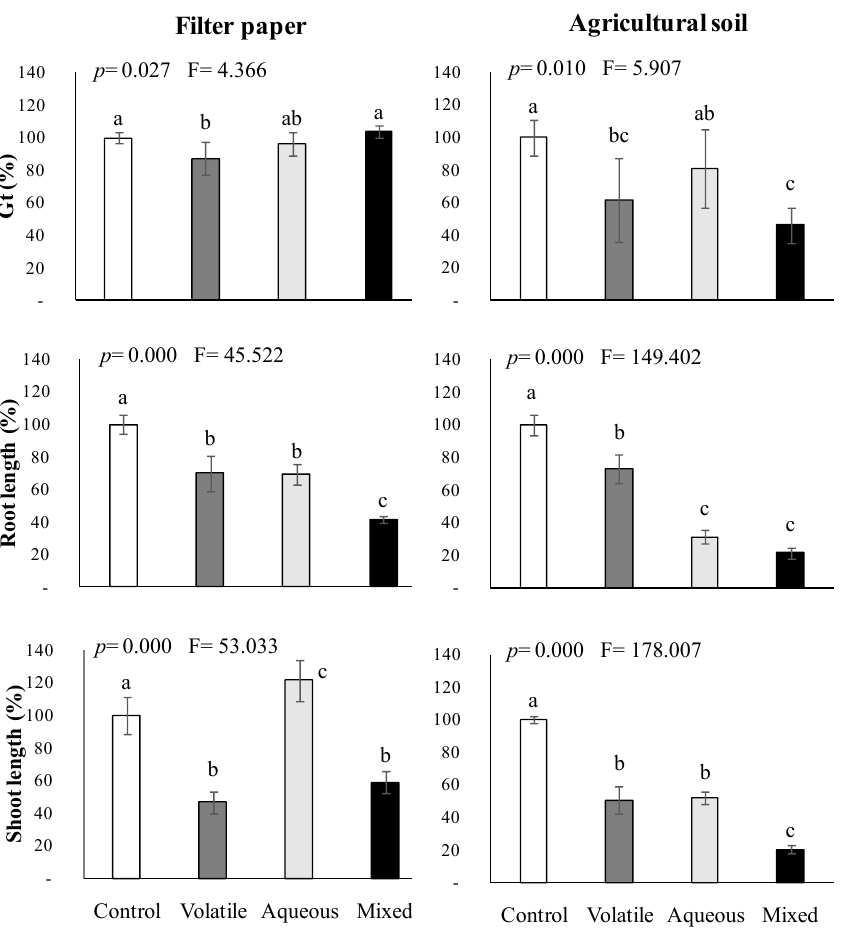
Figure 4. Effects of volatile compounds naturally released from the flowering foliage of Cytisus scoparius and its aqueous extract, acting separately or concomitantly in 1 L hermetic chambers, on the total percentage of germinated seeds (Gt) and early growth of Amaranthus retroflexus placed on filter paper or agricultural soil. Mean values of four replicates are represented in percentage relative to control. Error bars represent standard deviation (S.D.). p - and F-values of the effects of treatments from one-way ANOVA or Kruskal-Wallis H tests are shown. Mean values labeled with distinct letters denote statistically significant differences among treatments (post-hoc LSD or Tamhane’s T 2 test). So far, only an approach by Dias and Moreira [15] studied the interactions between the volatile compounds emitted by a plant and its aqueous extract. These authors discovered that the volatiles emitted by Cistus ladanifer intact leaves inhibited the germination of Trifolium subterraneum , but only when the water-soluble compounds were present. From our results (Figure 4), when assayed on filter paper, we found significant phytotoxic interactions between the naturally emitted VOCs and the aqueous extract on the root elongation of A. retroflexus , attaining 60% inhibition ( p ≤ 0.001). Conversely, inhibition of germination and shoot growth of the seeds placed on filter paper was only attributed to the VOCs released into the hermetic chamber; however, when added to fresh soil, and according to Pardo-Muras et al. [23], the aqueous extract of C. scoparius became significantly more effective in preventing root and shoot elongations. This time, excitingly, the soil appeared to promote synergistic interactions among the released volatiles and the